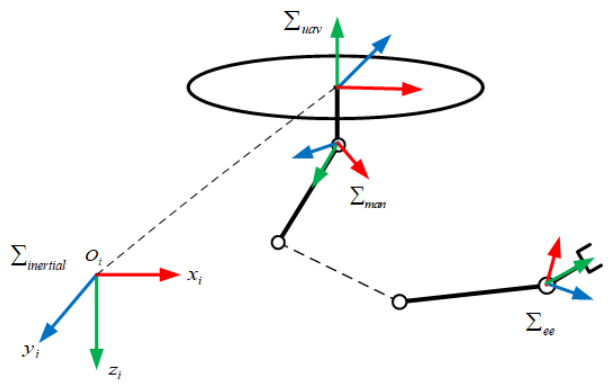
Figure 1. Reference frames of the UAM system.